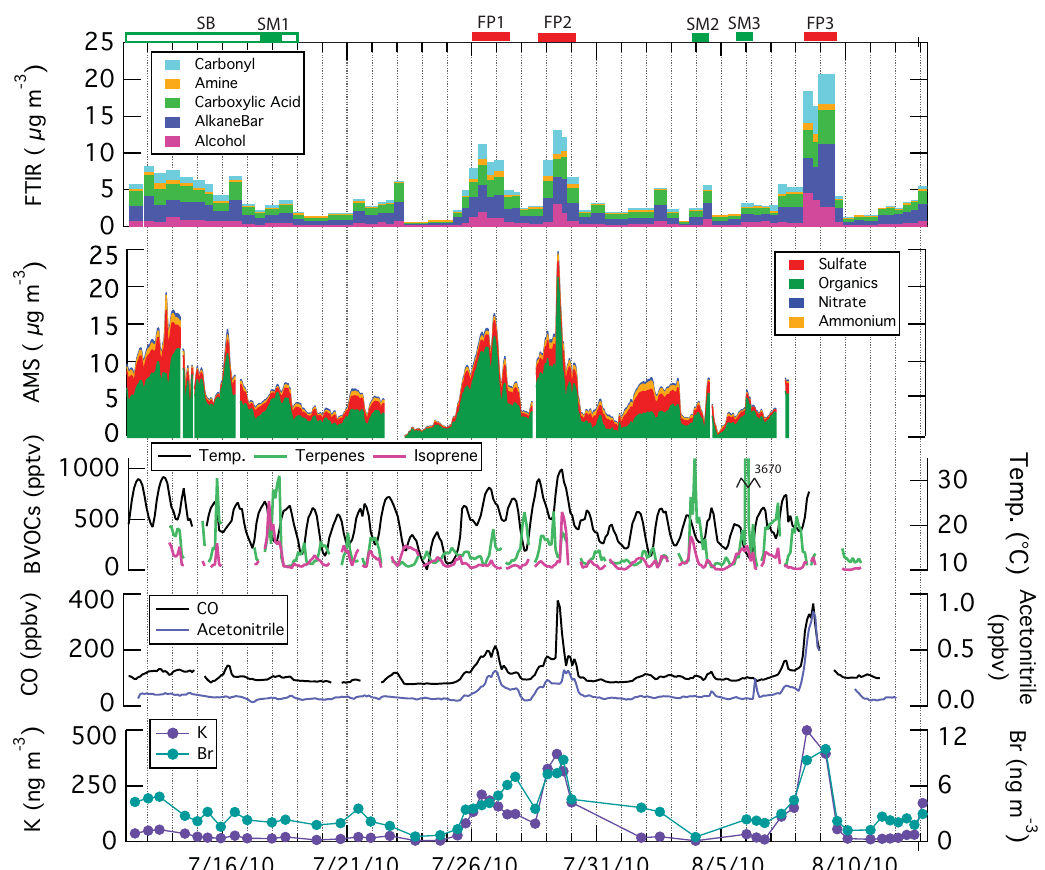
Fig. 1. Time series of submicron aerosol components and gas-phase tracers with stressed boreal (green outline), sawmill (green box) and fire (red box) periods denoted at figure top. (A) Organic functional groups from FTIR, including alcohol (pink), alkane (blue), carboxylic acid (green), amine (orange), and carbonyl (teal). (B) Nonrefractory organic aerosol from C-ToF-AMS including organics (green), sulfate (red), ammonium (orange), and nitrate (blue). (C) 2h average sum of monoterpenes (light green), isoprene (pink), and temperature (black). (D) 2h average CO (black) and acetonitrile (violet). (E) XRF potassium (purple) and XRF bromine (teal) for subset of FTIR filters analyzed by XRF. Stressed boreal periods were identified by several weeks of unusually high temperatures prior to and during the first week of the campaign (Bäck et al., 2013) and sawmill periods by their enrichment of ( + )- α -pinene over its ( − )- α -pinene enantiomer, coinciding with abnormally high nighttime spikes in monoterpene and isoprene concentrations (Williams et al., 2011). Fire periods were defined as times that exhibited acetonitrile, CO, potassium, and bromine concentrations, with percent increases of greater than 100% above background concentrations.